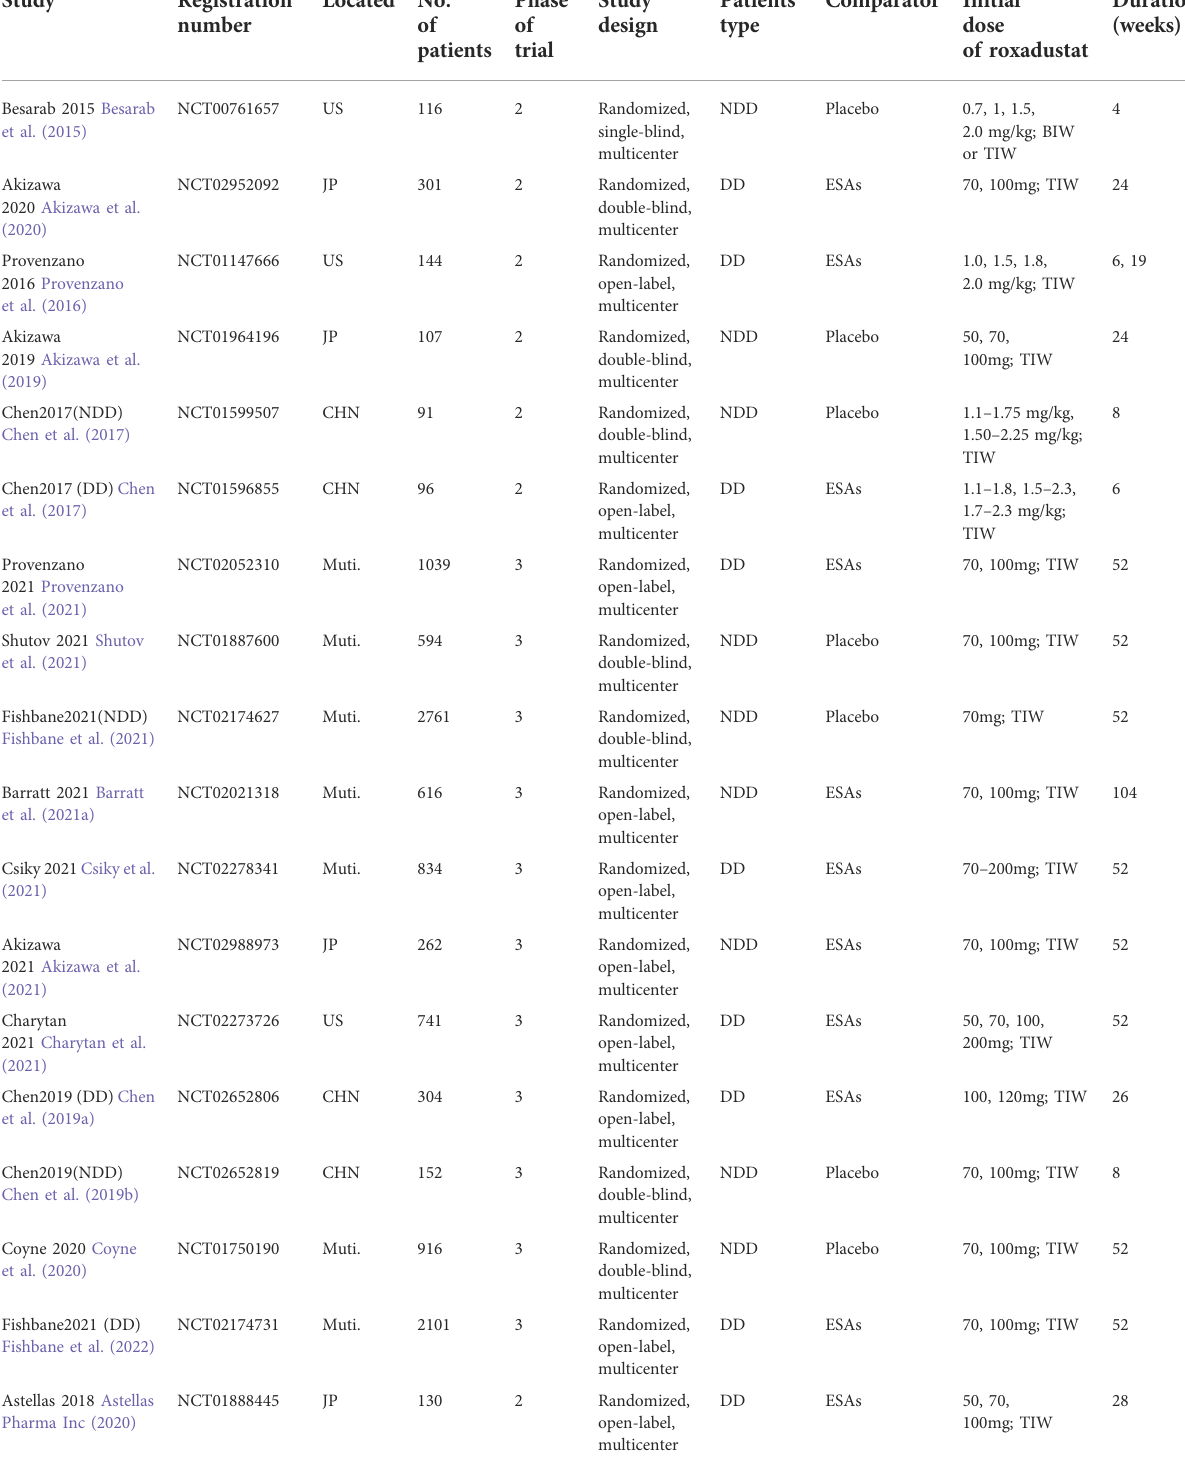
TABLE 1 Basic characteristics of included